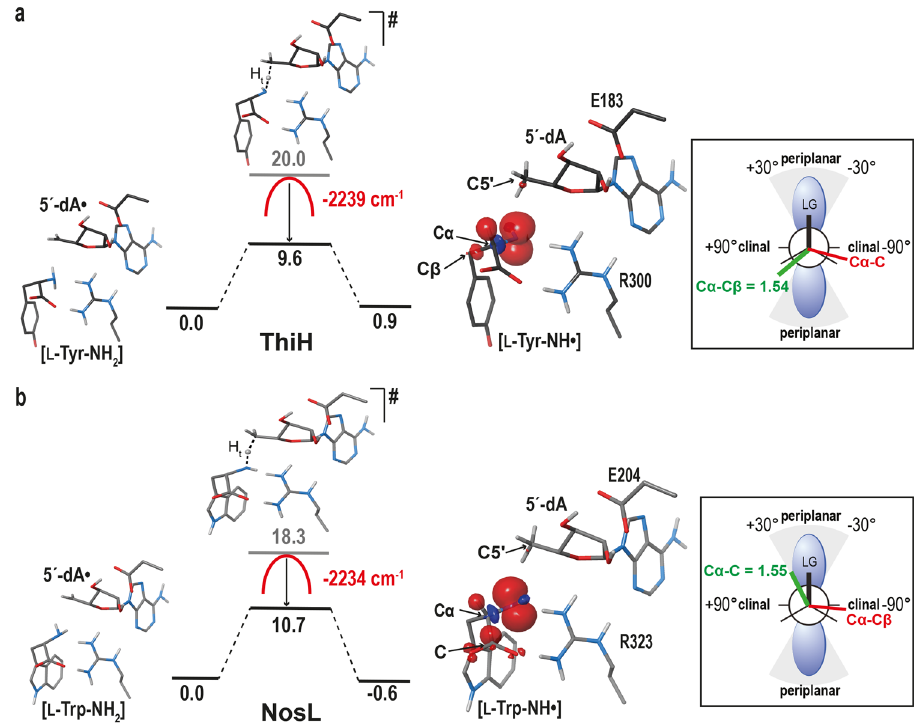
Fig. 4 Substrate hydrogen abstraction by 5´-dA • . a Reaction energy pro fi le for the attack by 5´-dA • leading to the formation of [L-Tyr-NH • ] - Φ (C β -C α – N-H) = 39.6°, ThiH product P in Supplementary Table 2 - within the Tc ThiH active site. Insert (right): Newman representation, adapted from reference 57 , of the dihedral angle between the partially occupied p orbital (blue) at the nitrogen radical center and the C α – C β bond (in green) or the C α – C bond (in red), where p -cresyl • (or • COO – ) is the leaving group (LG). The periplanar region is indicated in gray, the rest being clinal. Although not optimal, the orbital overlap allows the C α – C β bond break while the C α – C bond break is not possible with the dihedral angle clearly lying in the clinal region. b [L-Trp-NH • ] - Φ (C β -C α – N-H) = 174.5°, NosL product P in Supplementary Table 2 - obtained from the NosL productive reactant R - Φ (C β -C α – N- H1) = 55°, Supplementary Fig. 14c - within the Sa NosL active site. Insert (right): Newman representation as in ( a ), showing that, in this case, the orbital overlap is maximized to break the C α – C bond with the corresponding dihedral lying in the periplanar region. By contrast, the dihedral corresponding to the C α – C β bond break clearly lies in the clinal region, impeding this reaction to occur. In ( a , b ), single point energies for reactants and products are given in kcal.mol − 1 ; the TS energy in gray corresponds to the calculated value from the IRC calculations while the one in black is the barrier taking into account the tunneling effect (see main text and Supplementary Methods for details); the value of the TS single imaginary frequency is indicated in red; for the reactant, transition state and product, a minimal model of the active site extracted from the corresponding QM/MM geometry is represented as sticks with C, N, O and H atoms in gray, blue, red and light gray, respectively; except for the 5´-dA C5´ atom, only polar hydrogens are shown for clarity; the hydrogen atom that is transferred is represented as a light-gray ball in the transition state; the spin density is shown for the product (the product geometries without the spin density are shown in Supplementary Fig.